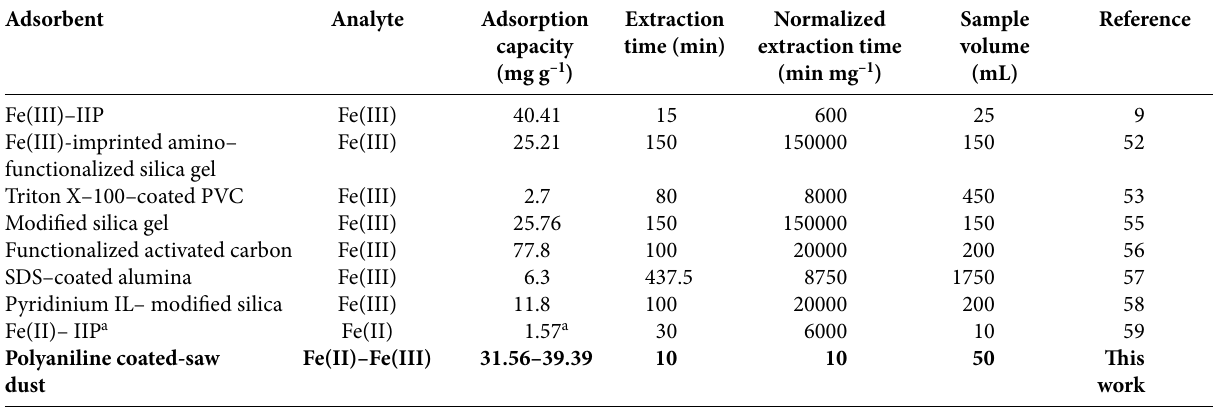
functionalized silica gel